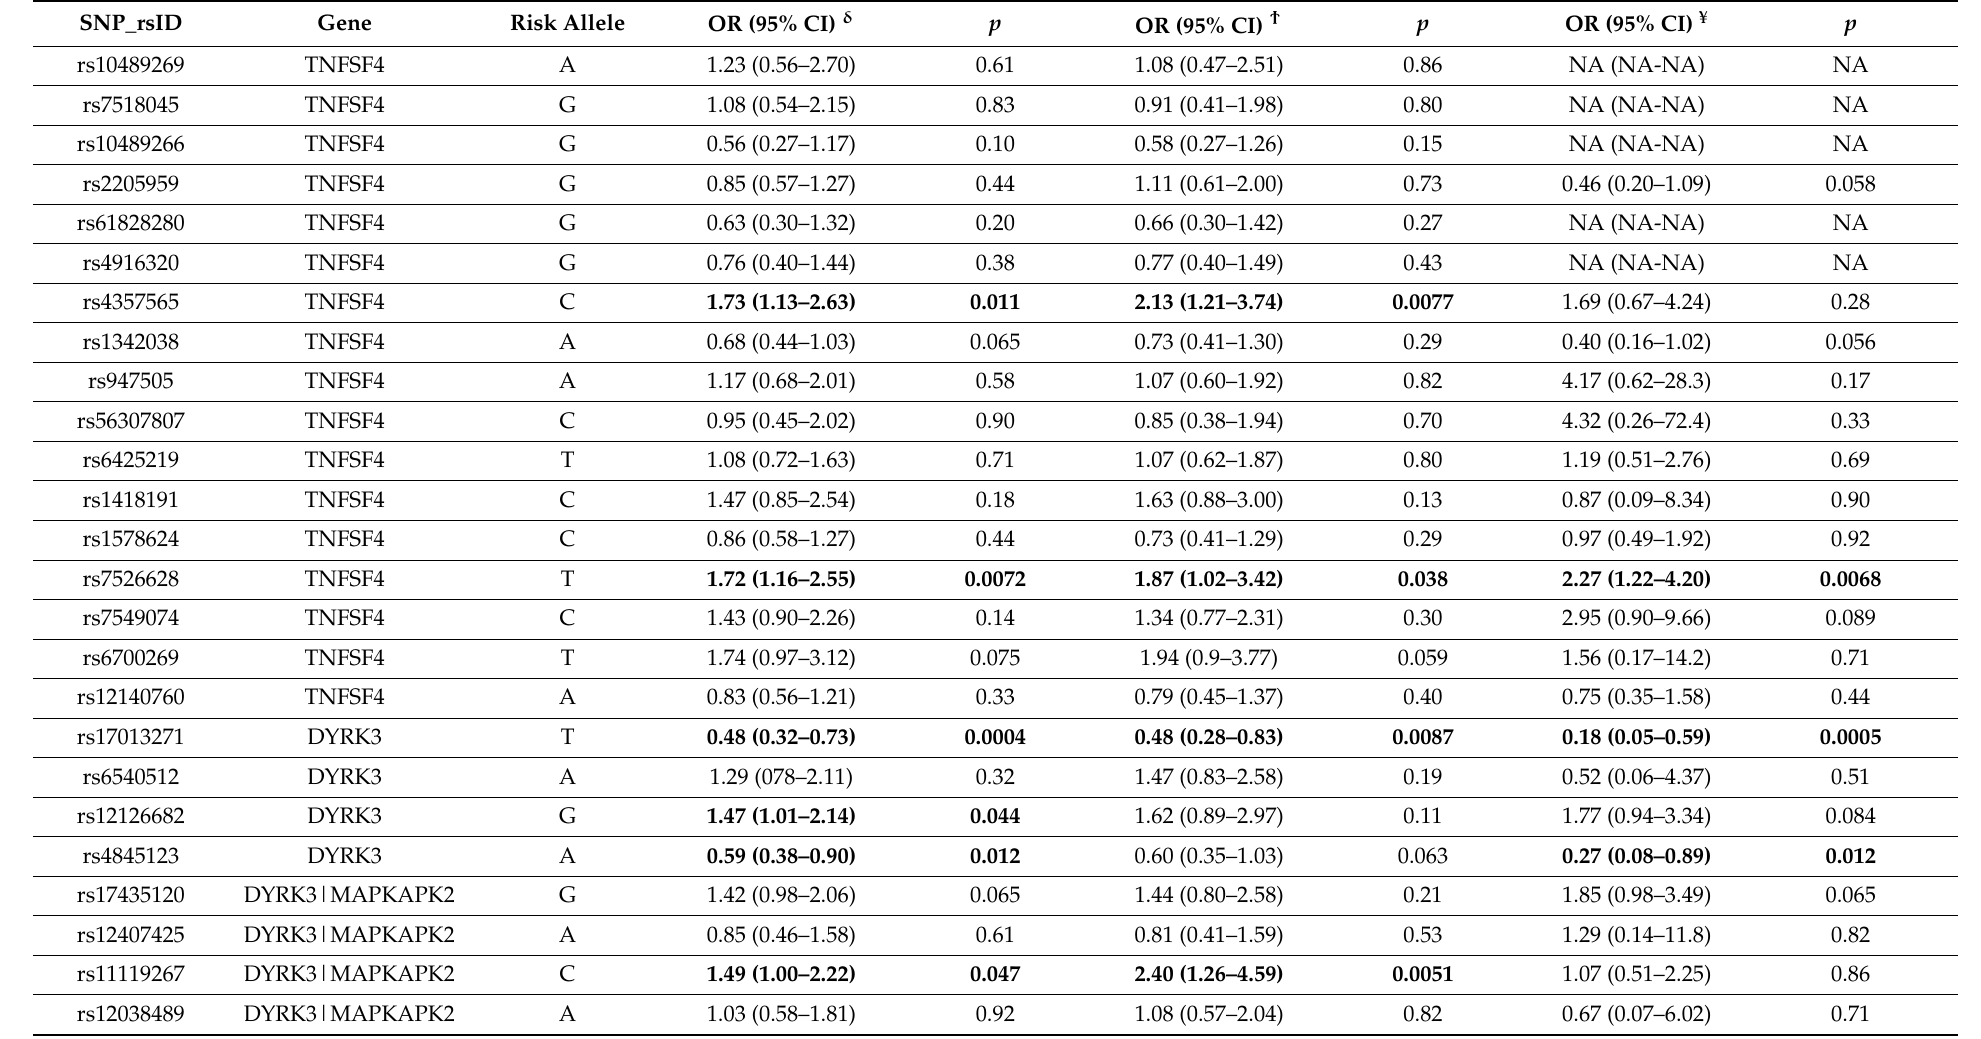
of inheritance was assumed (C/C vs. C/T+T/T), which reinforced the role of the MAPKAPK2 gene these genetic associations remained significant after correction for multiple testing, we found that carriers of the risk MAPKAPK2 rs12137965G allele showed increased levels of CD38+IgM-IgD- plas- mablasts in blood ( p = 0.00086; Figure 2A). In addition, we observed that carriers of the MAP- KAPK2 rs12137965G/G genotype also showed decreased levels of thymic stromal lymphopoietin (TSLP) in serum ( p = 0.00097; Figure